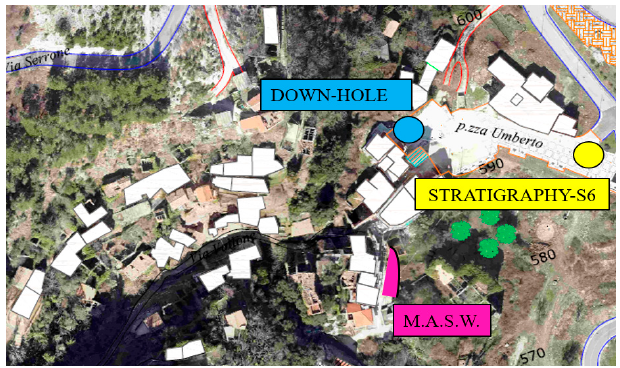
Figure 10. The identification of the in-situ tests.